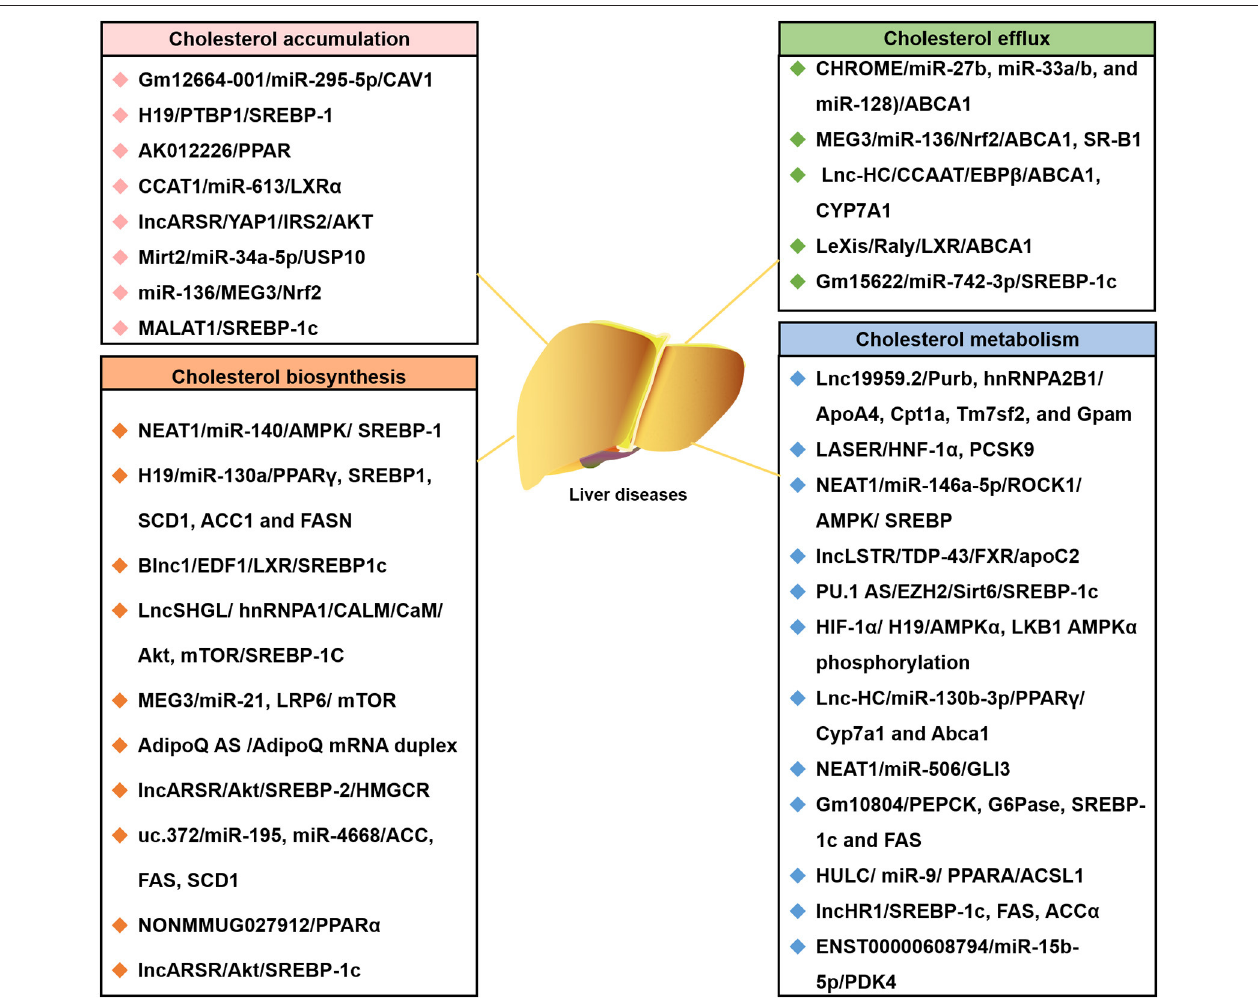
FIGURE 3 | The lncRNA-associated ceRNA networks affect the four common cholesterol transport models of liver diseases. Representative lncRNA-ceRNA networks are listed. They highlighted the involvement of lncRNA-ceRNA networks in four common cholesterol transport models of liver diseases: cholesterol accumulation, cholesterol efflux, cholesterol biosynthesis, and cholesterol metabolism. ACC α , Acetyl-CoA carboxylase α ; CaM, calmodulin; FAS, fatty acid synthase; G6Pase, glucose-6-phosphatase; hnRNPA1, heterogeneous nuclear ribonucleoprotein A1; LncLSTR, liver-specific triglyceride regulator; LncSHGL, hepatic gluconeogenesis, and lipogenesis; Mirt2, long non-coding RNA myocardial infarction associated transcript 2; PEPCK, phosphoenolpyruvate carboxykinase.